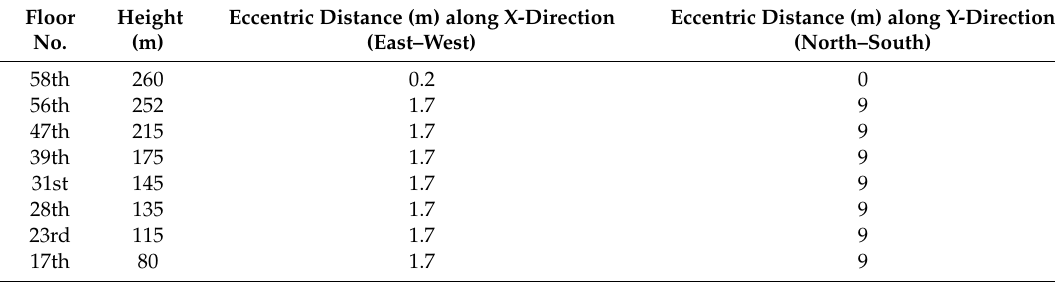
Figure 2. Three functional layers involved in the structural health monitoring (SHM) system.